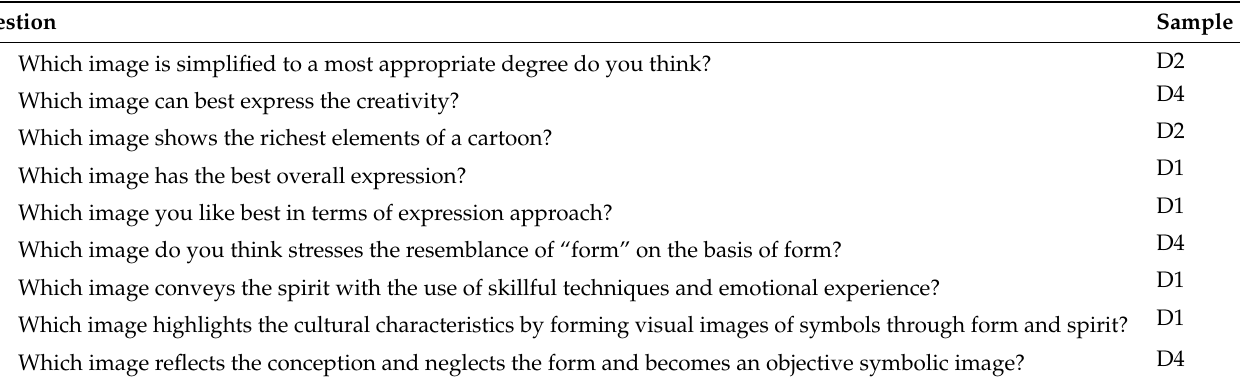
Table 5. The sample that received the highest recognition in evaluation of preferences I and II.